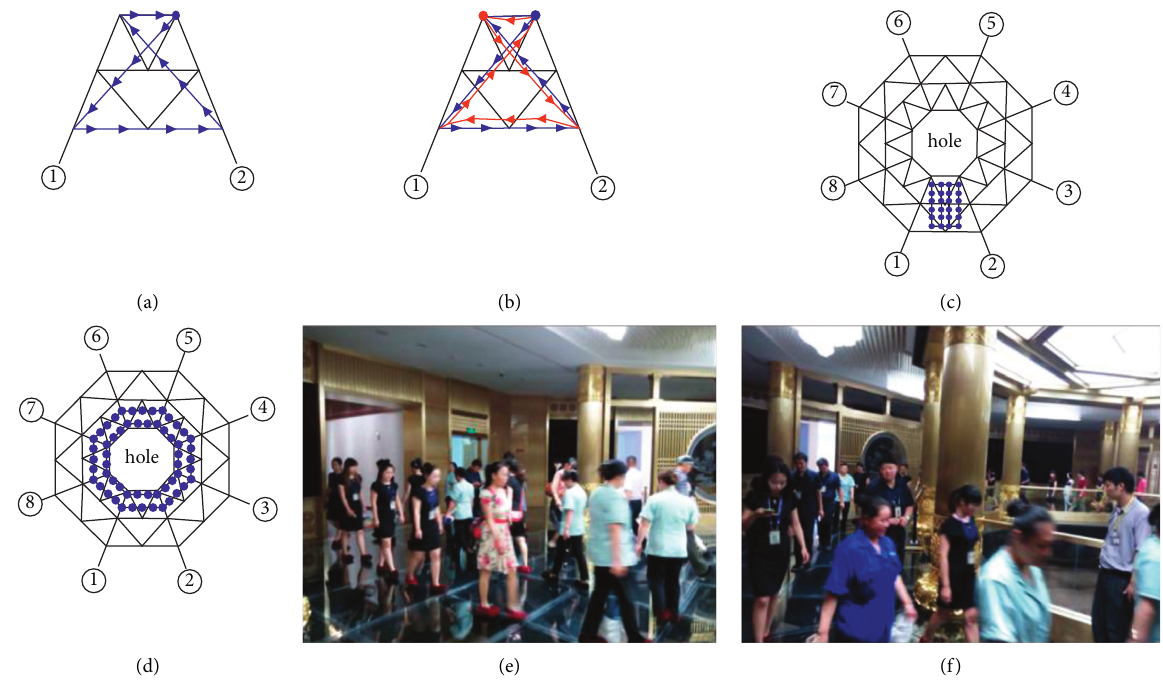
Figure 5: Trajectory of walking people. (a) Single walking. (b) Pair walking. (c) 24 people walking. (d) 56 people walking. (e) 24 people walking experiment. (f) 56 people walking experiment.